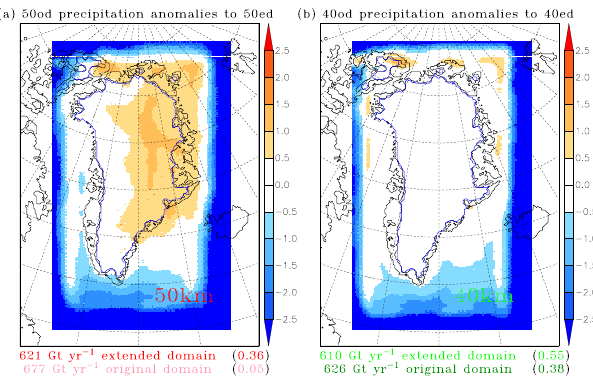
Fig. 6. (a) Annual precipitation anomalies (in standard deviation) of the 50km resolution outputs from the MAR model running over the original domain (50od), compared to the 50km resolution out- puts from MAR simulation over the extended domain (50ed), over the 1990–2010 period. Positive (negative) anomalies mean higher (lower) precipitation simulated by 50od than 50ed. On the bottom left side of the view is the annual amount of precipitation (Gtyr − 1 ) from 50ed (in red) and 50od (in pink). On the bottom right side of the view, in brackets, is the skill score of 50ed (in red) and 50od (in pink) compared to the 15km MAR outputs (15rt). (b) The same as (a) , but for the 40ed (in clear green) and 40od (in dark